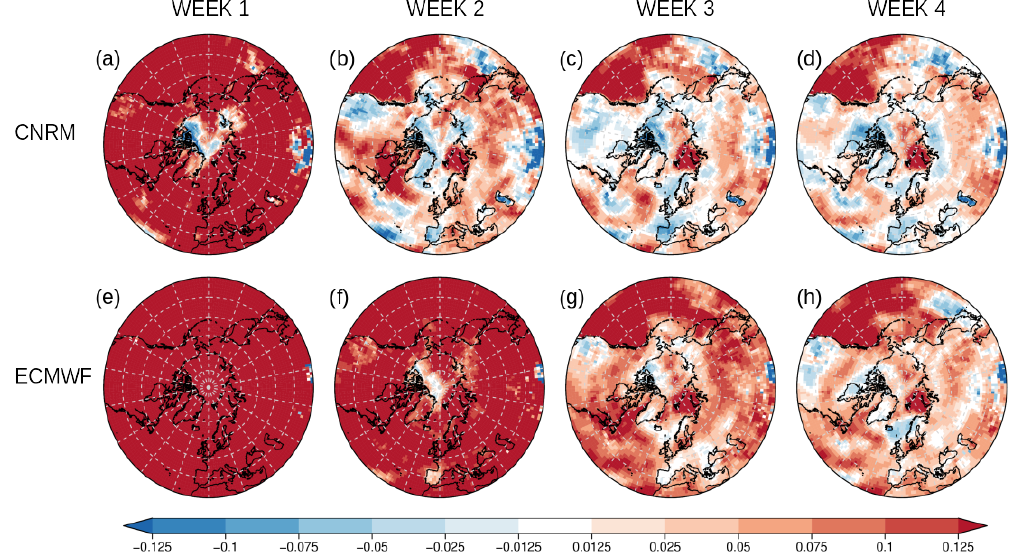
Figure 2. Fair CRPSS for week 1 to week 4 forecasts for CNRM (a–d) and ECMWF (e–h) forecast systems against climatological forecasts (see text). Red shade indicates that the actual forecasts are more skillful than the climatological counterparts.